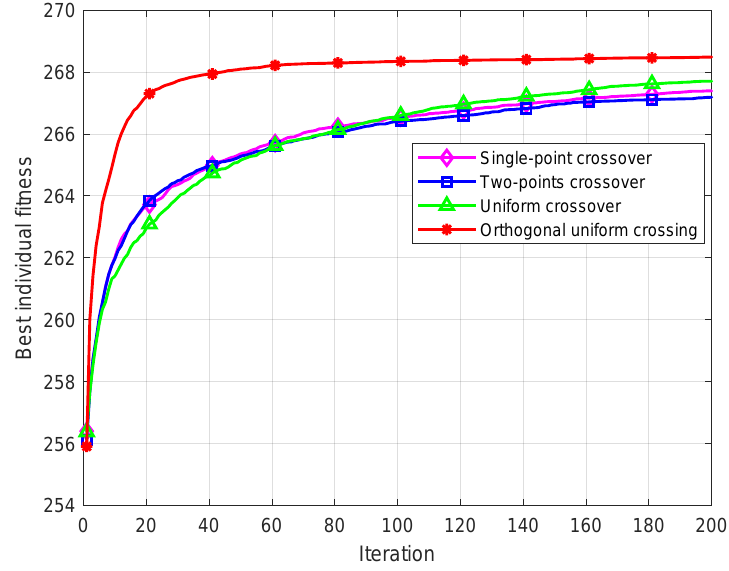
Figure 3. Simulation graph of crossover operator performance.